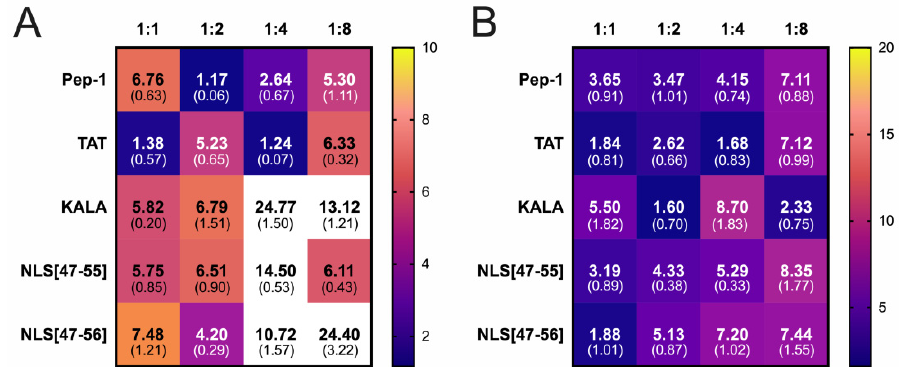
Figure 14. Results of 48 h culture in the presence of complexes in CRs of 1:1, 1:2, 1:4 and 1:8. The complexes were formed using incubation of 2 μ g pmaxGFP with chosen CPPs at 21 °C for 15 min. Bar = 50 μ m. CR, charge ratio.